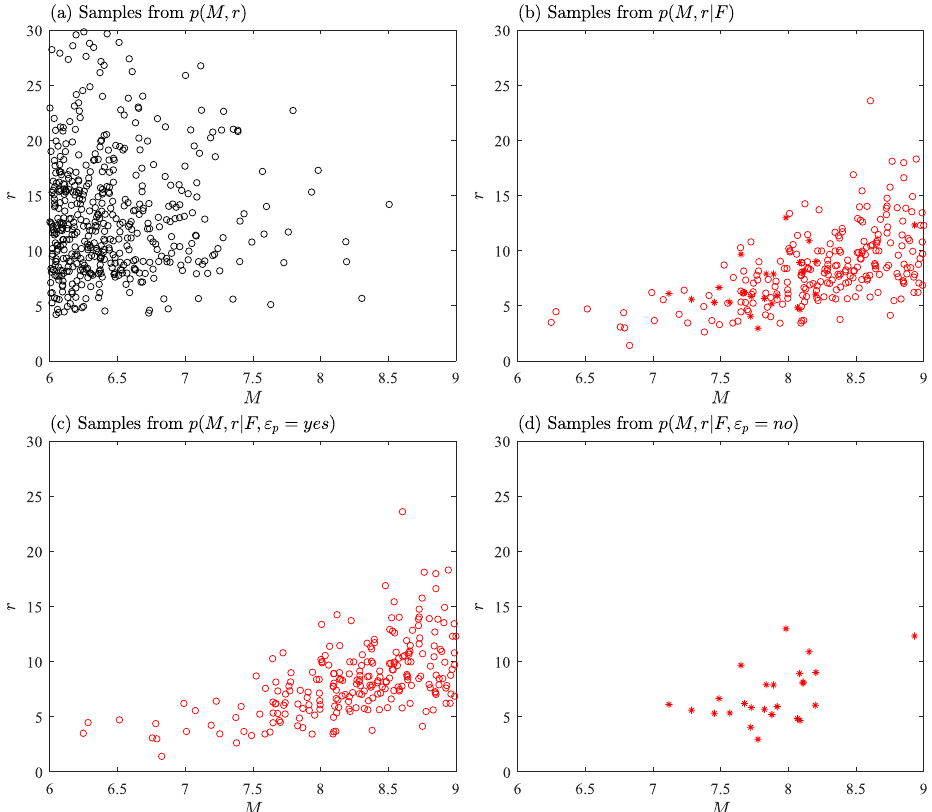
Figure 13. Samples from ( a ) p ( M , r ) , ( b ) p ( M , r | F ) , ( c ) p ( M , r | F , ε p = yes ) , and ( d ) p ( M , r | F , ε p = no ) . All the plots are for chevron-braced